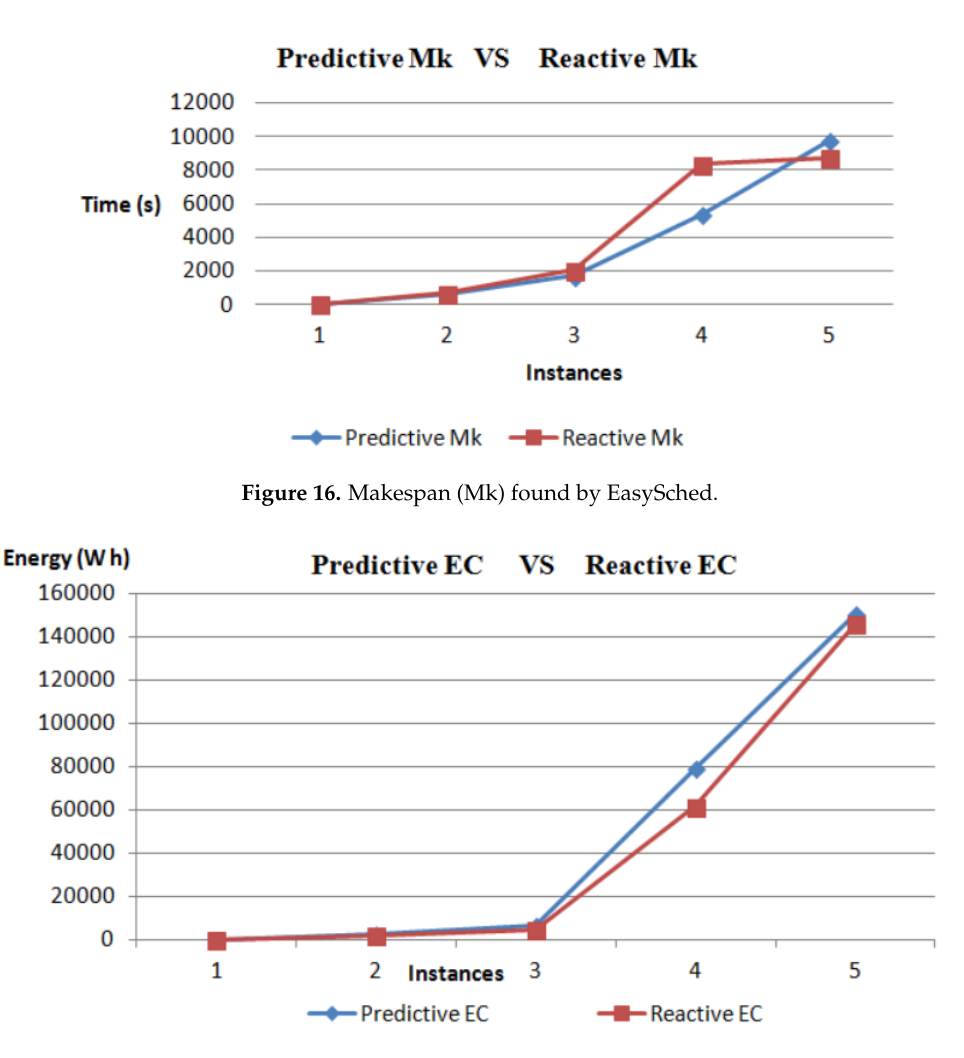
Figure 17. Energy consumption (EC) found by EasySched.